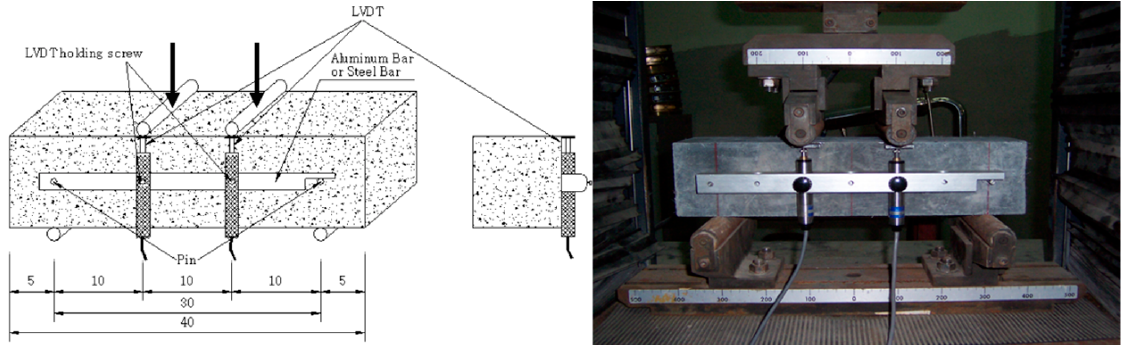
Figure 2. Experimental setup for the flexural tensile strength measurement.